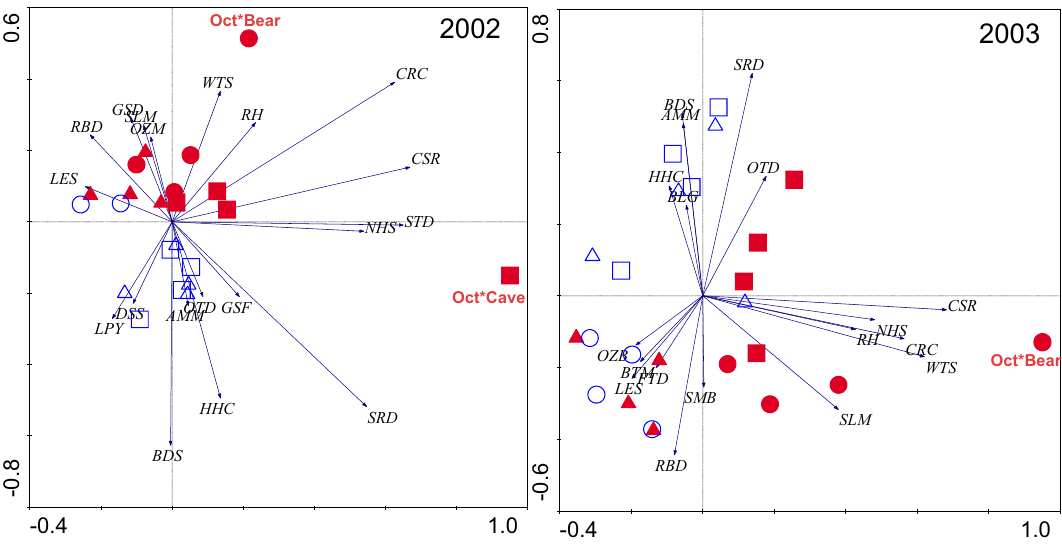
Figure 7. Redundancy analysis examining the relationship between fish species densities and season by stream interactions in 2002 and 2003. Filled symbols (red) denote Runoff/Intermittent Flashy streams and open symbols (blue) denote Groundwater Flashy streams. Arrows represent fish species densities. Fish species abbreviations are as in Table 2. Centroids denote season by stream categories. Runoff/Intermittent Flashy streams are Bear Creek = circles, Cave Creek = Squares, Falling Water Creek = triangles, and Groundwater Flashy streams are Sylamore Creek = circles, Tomahawk Creek = squares, and Water Creek = triangles. Percent variance of species-environment relationships explained was 2002 RDA axis 1 = 78.9%, RDA axis 2 = 19.3%; 2003 RDA axis 1 = 75.9%, RDA axis 2 = 20.8%. Figure produced with CANOCO 4 31